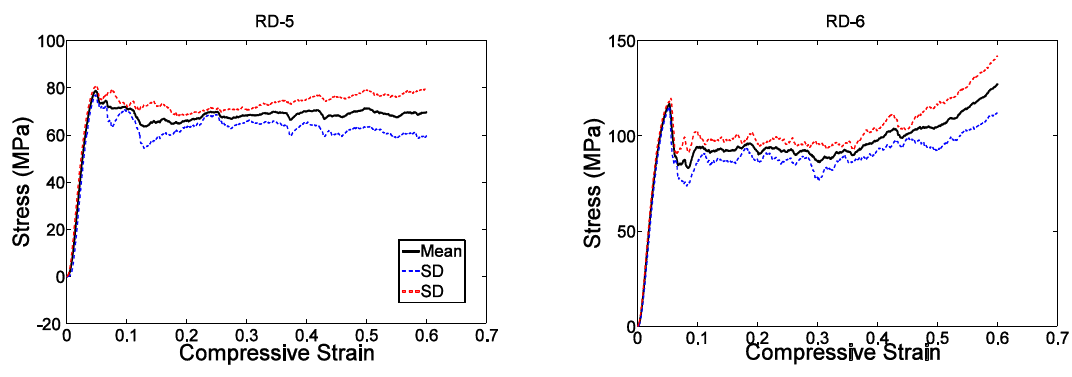
Figure 7. Compressive stress- versus -compressive strain for specimens based on the rhombic dodecahedron unit cell and with different porosities (see Table 2).